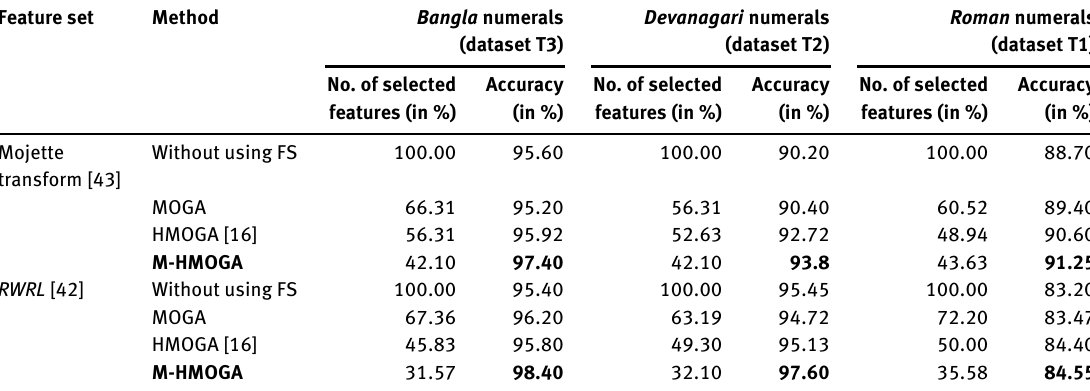
Table 9: Comparison of the Proposed FS Model Called M-HMOGA for Two Feature Sets with MOGA and HMOGA Using KNN as the Classifier in E2 (Best Results Are Made Bold).